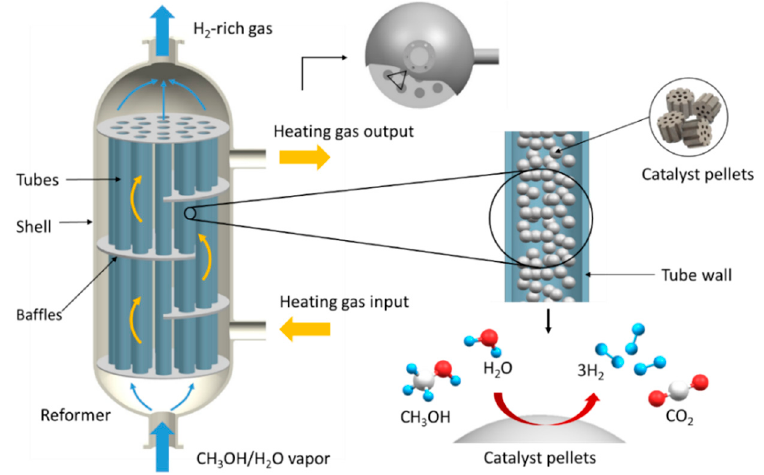
Figure 1. Structure of the multi-tubular packed-bed reformer for methanol steam reforming.